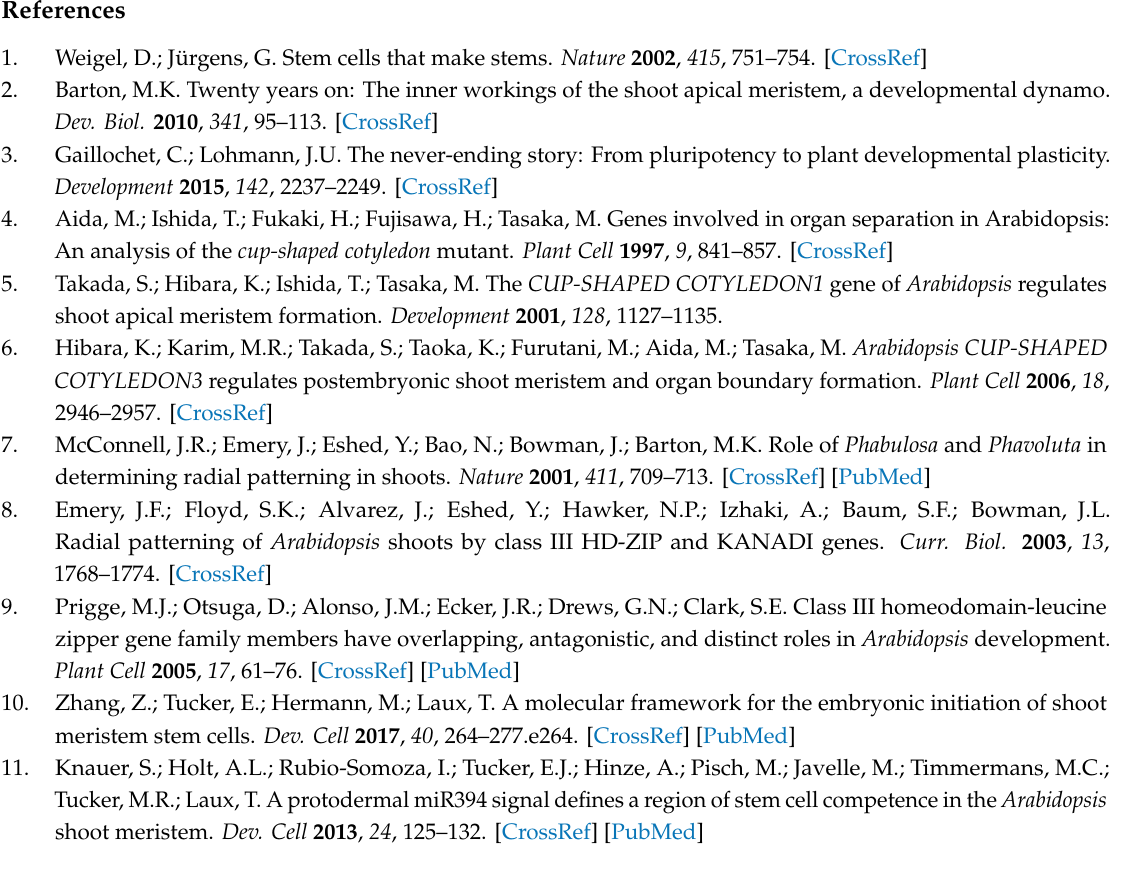
Genes in Bending Cotyledon Stage Embryos. Table S4: Mutants used in this analysis. Table S5: Gene-Specific Primers for Rescue Constructs. Table S6: Primers used for cloning probe templates for in situ hybridization. Table S7: Primers used for qRT-PCR experiments. Figure S1: Expression of candidate downstream genes in wild-type Ler and cuc1-1 cuc2-1 embryos. Figure S2: Examples of rescued and non-rescued plants. Text S1: Screening of additional genes regulated by CUC1 and